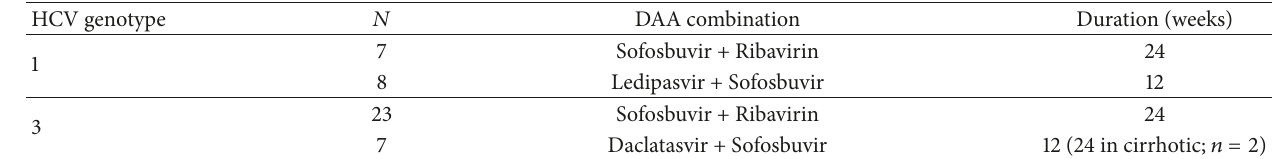
Table 1: Combination of DAAs and treatment according to genotype and DAA availability.